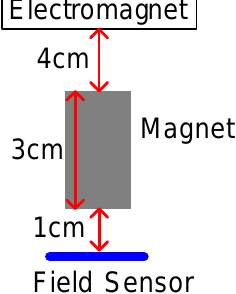
Figure 10. Sketch of magnet position.